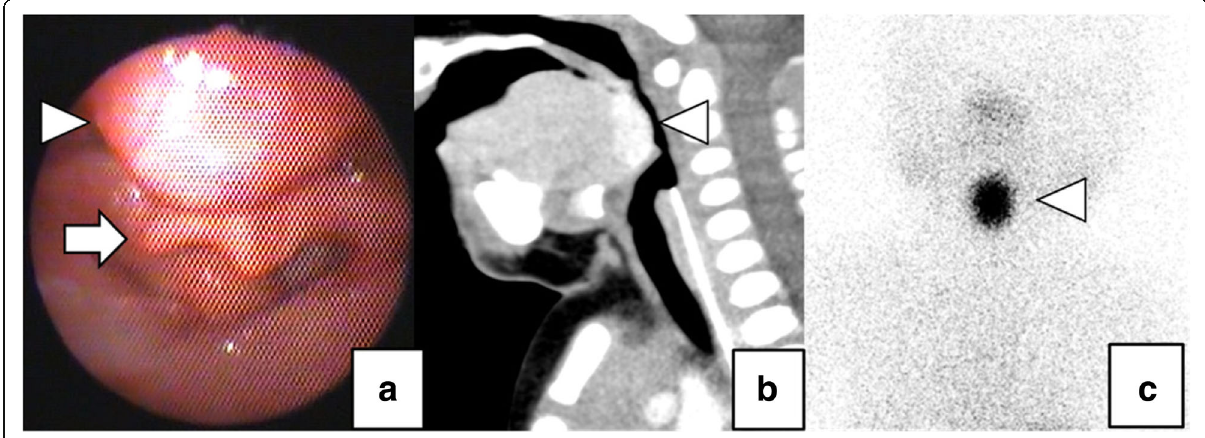
Fig. 1 Preoperative imaging tests. Laryngeal endoscopy revealed a lingual mass (arrow head) compressing the epiglottis (arrow) ( a ). Enhanced CT ( b ) and thyroid scintigraphy using iodine-123 ( c ) revealed that the mass (arrow heads) was an ectopic thyroid and that there was no normal pretracheal thyroid